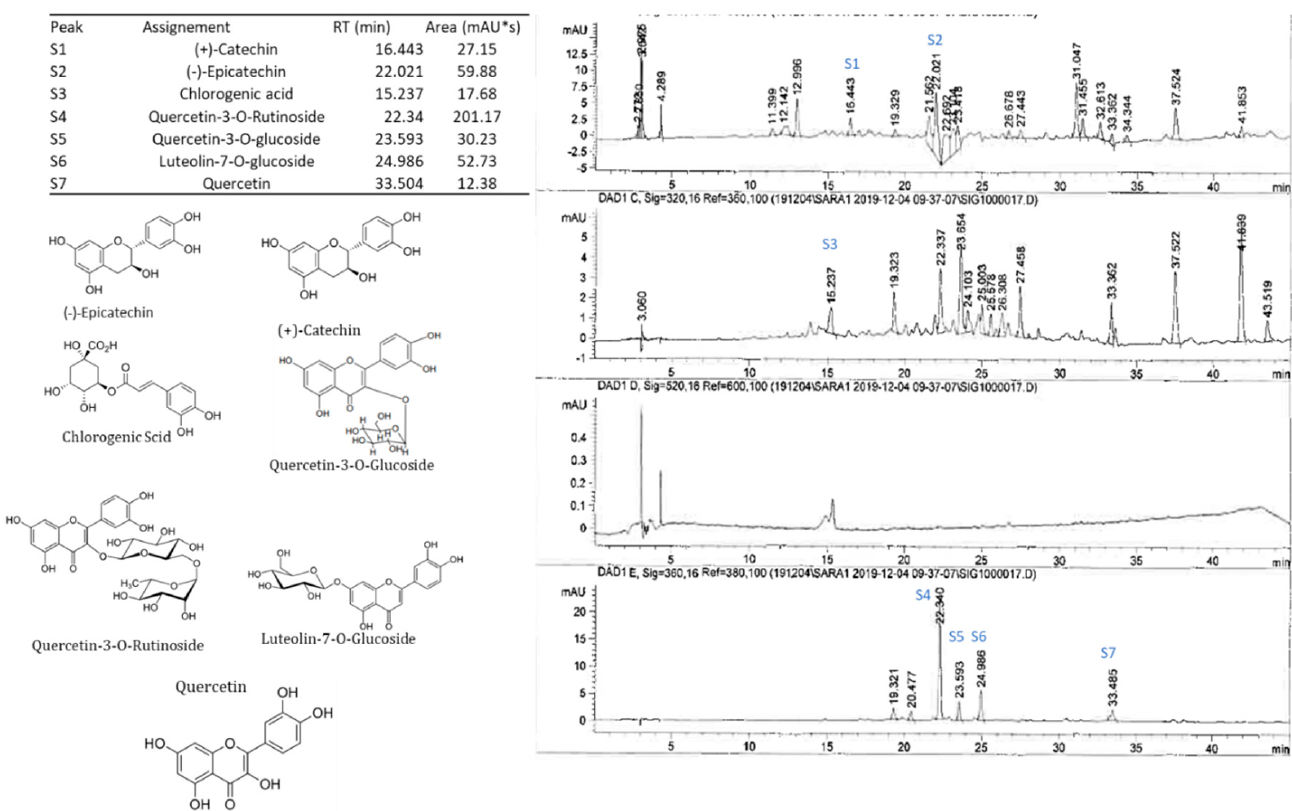
Figure 2. HPLC-DAD profile, chemical structures of the main phenolic compounds identified in the fig pulp. Example of the cultivar INRA 2015.